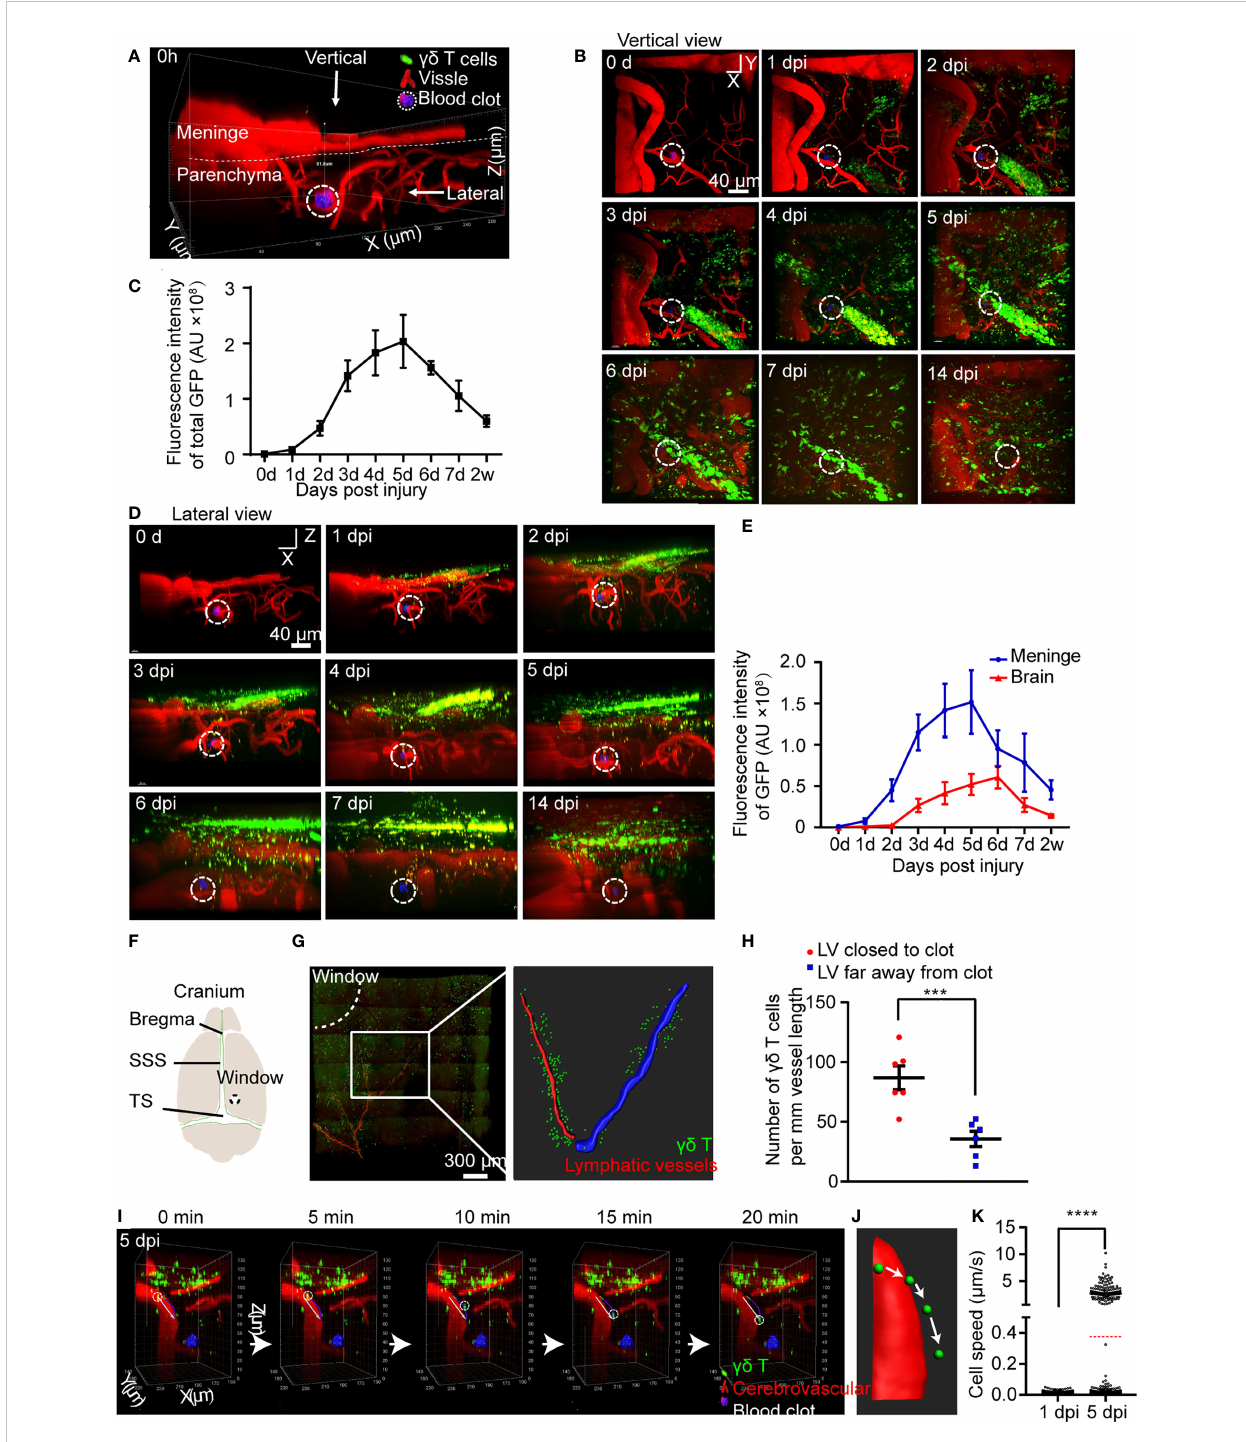
FIGURE 1 CMBs induce migration of meningeal gd T cells to brain parenchyma. (A – E) In vivo imaging of gd T cells (green) and blood vessels (red) after CMBs (dotted circles) using TCR- d EGFP/+ mice. Reconstruction of stacked sections shows the distribution of gd T cells at different days post injury (dpi) through the vertical (B) and lateral (D) view. Total gd T cells disclosed by GFP intensity gradually increase from 1 to 5 dpi and then decrease (C) ; mean ± SEM, n ≥ 3 mice). (F) Schema illustrates opening window (dotted circle) in the cranium (SSS: superior sagittal sinus, TS: transverse sinus). (G, H) Relative location of meningeal lymphatic vessels (LVs; anti-Lyve-1 immunostaining, red in left panel) and gd T cells (green) shows that the LV closer to the injury spot (the LV indicated by drawing red line, right panel) is surrounded by more gd T cells than that farther away from the injury site (the LV indicated by drawing blue line, right panel) (G) , with a signi fi cant increase indicated by quanti fi cation of gd T cells (H) ; n=3 mice, Student ’ s t-test , *** P <0.001). (I – K) In vivo imaging reveals the dynamic movement of gd T cells in the brain parenchyma (I) ; reconstructed images indicate the moving trajectory (J) , and statistical analysis shows a signi fi cant increase of moving speed at 5 dpi compared with that at 1 dpi (K) ; average speed indicated as the red dotted line; **** P <0.0001, Student ’ s t -test, n ≥ 8